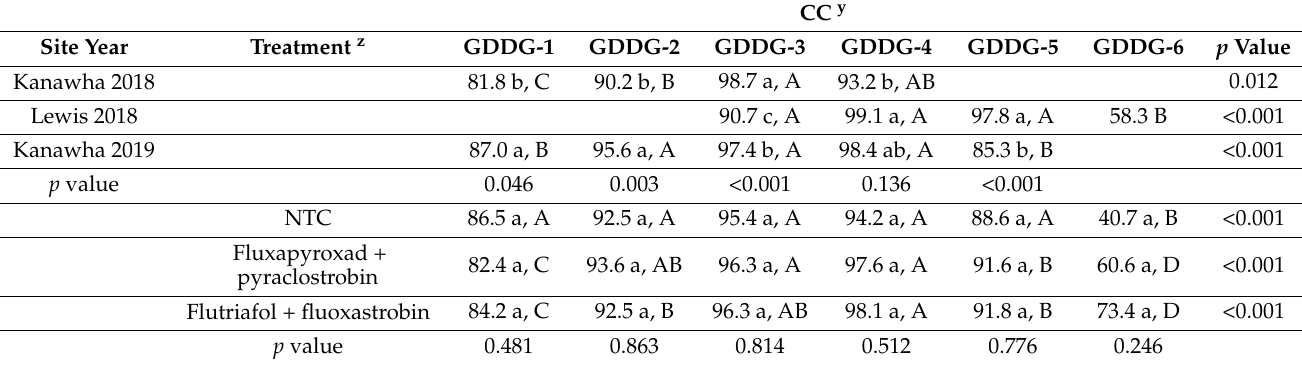
x Means within a column followed by the same lower-case letter and means within a row followed by the same upper-case letter do not differ significantly at α = 0.1. Means were separated using the “Lines” option in LSMEANS statement. y GDDG = Growing degree day group. The range between GDDs within GDDG-1 was 1280 to 1298, 1542 to 1560 for GDDG-2, 1808 to 1858 for GDDG-3, 2140 to 2243 for GDDG-4, 2344 to 2711 for GDDG-5, and 2832 for GDDG-6. z Treatments = Non-treated controls (NTCs) did not receive a fungicide